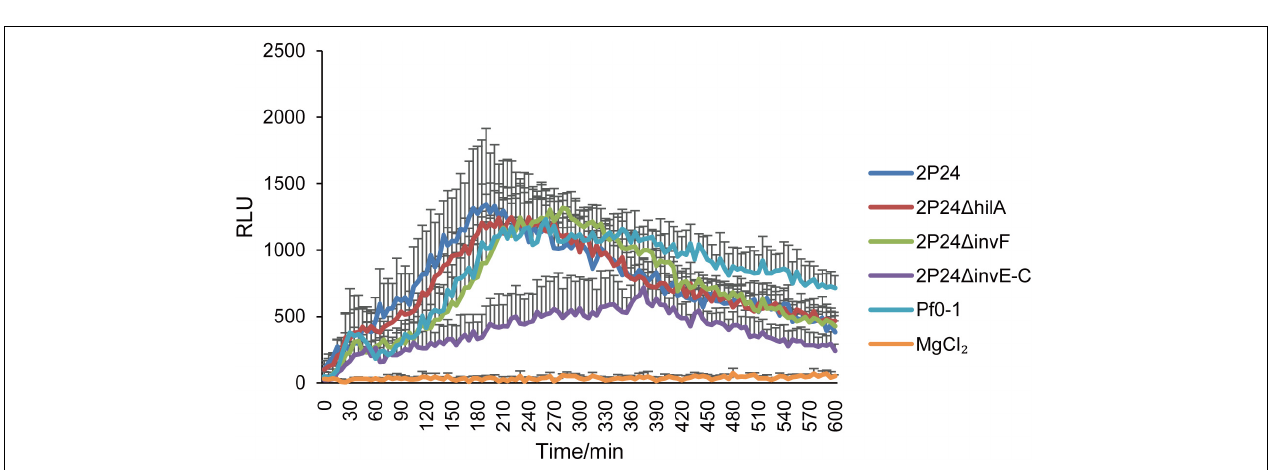
FIGURE 9 | ROS assay of strain 2P24 and SPI-1 related mutants. The bacteria were infiltrated at 5 × 10 8 cfu/mL into N. benthamiana leaves and 12 h later assayed for ROS burst using L-012 chemiluminescence. P. fluorescens Pf0-1 was used as the positive control and 10 mM MgCl 2 as the negative control. Data are means of six replicates. Error bars represent